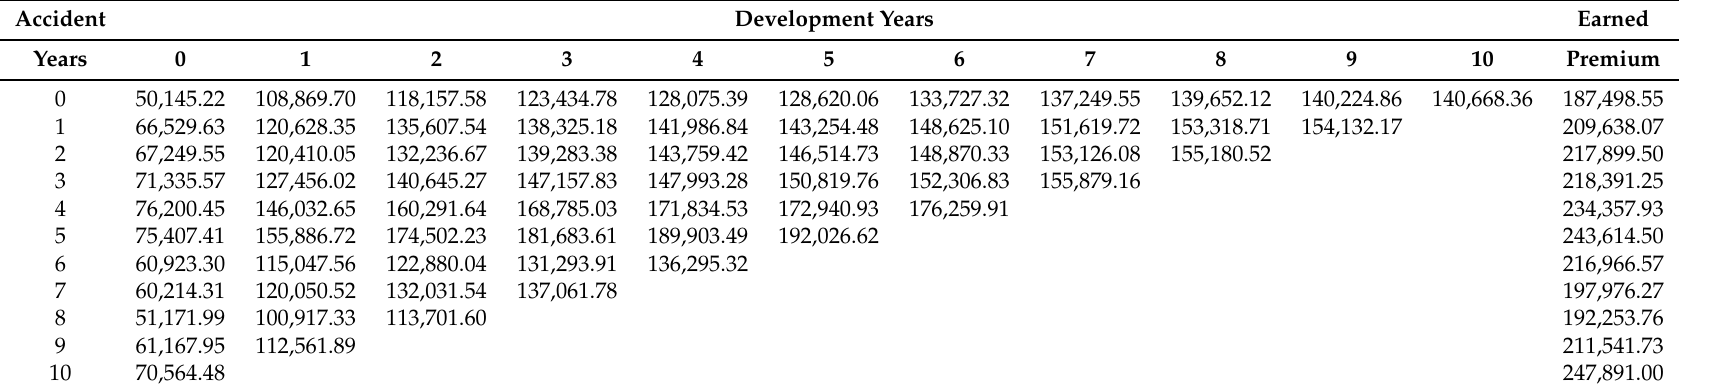
Table A1. Triangle of cumulative payments and earned premiums. Amounts in thousands of euros.